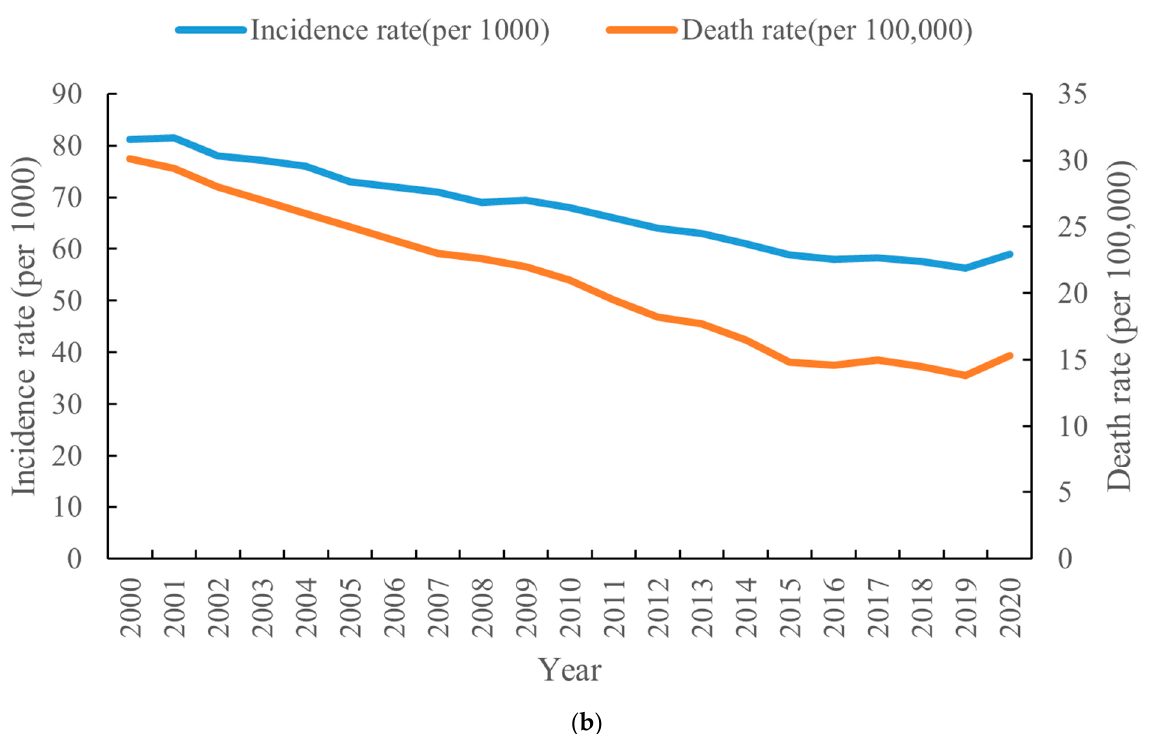
Figure 1. Change trend of the global malaria epidemic from 2000 to 2020. ( a ) Number of malaria cases and deaths; ( b ) incidence rate (1000) and death rate (100,000).